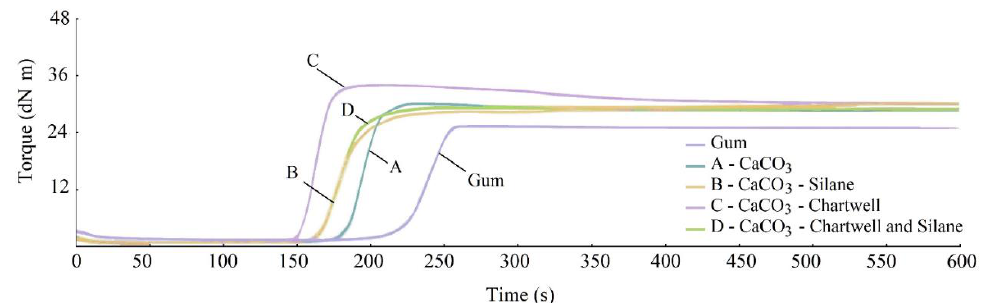
Figure 3. Rheometric curve of the NR composites with 40 phr of calcium carbonate (CaCO 3 ) measured with 1 ◦ of disk oscillation and isotherms at 150 ◦ C. Only the coupling agents were changed. Gum is included as a reference point. Table 3. Rheometric properties of the NR composites with 40 phr of calcium carbonate (CaCO 3 ) measured with 1 ◦ of disk oscillation and isotherms at 150 ◦ C. Only the coupling agents were changed. Gum is included as a reference